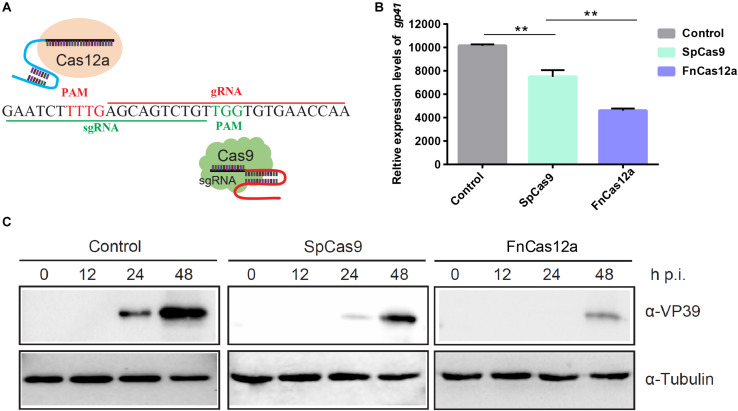
Comparative analysis of the antiviral ability of CRISPR/Cas9 and CRISPR/Cas12a. (A) Comparison of CRISPR/Cas9 versus CRISPR/Cas12a-mediated genome editing. Cas12a, Cas9, crRNA, and PAM are shown. (B) Analysis of BmNPV DNA replication in CRISPR/Cas12a and CRISPR/Cas9 systems. Error bars represent standard deviations of three biological replicates. ** represents statistically significant differences at P < 0.01. (C) Western blot analysis of CRISPR/Cas12a and CRISPR/Cas9 system mediated antiviral activity monitored by the levels of the VP39 (top) and Tubulin (bottom). The ratios of different types of mutations.